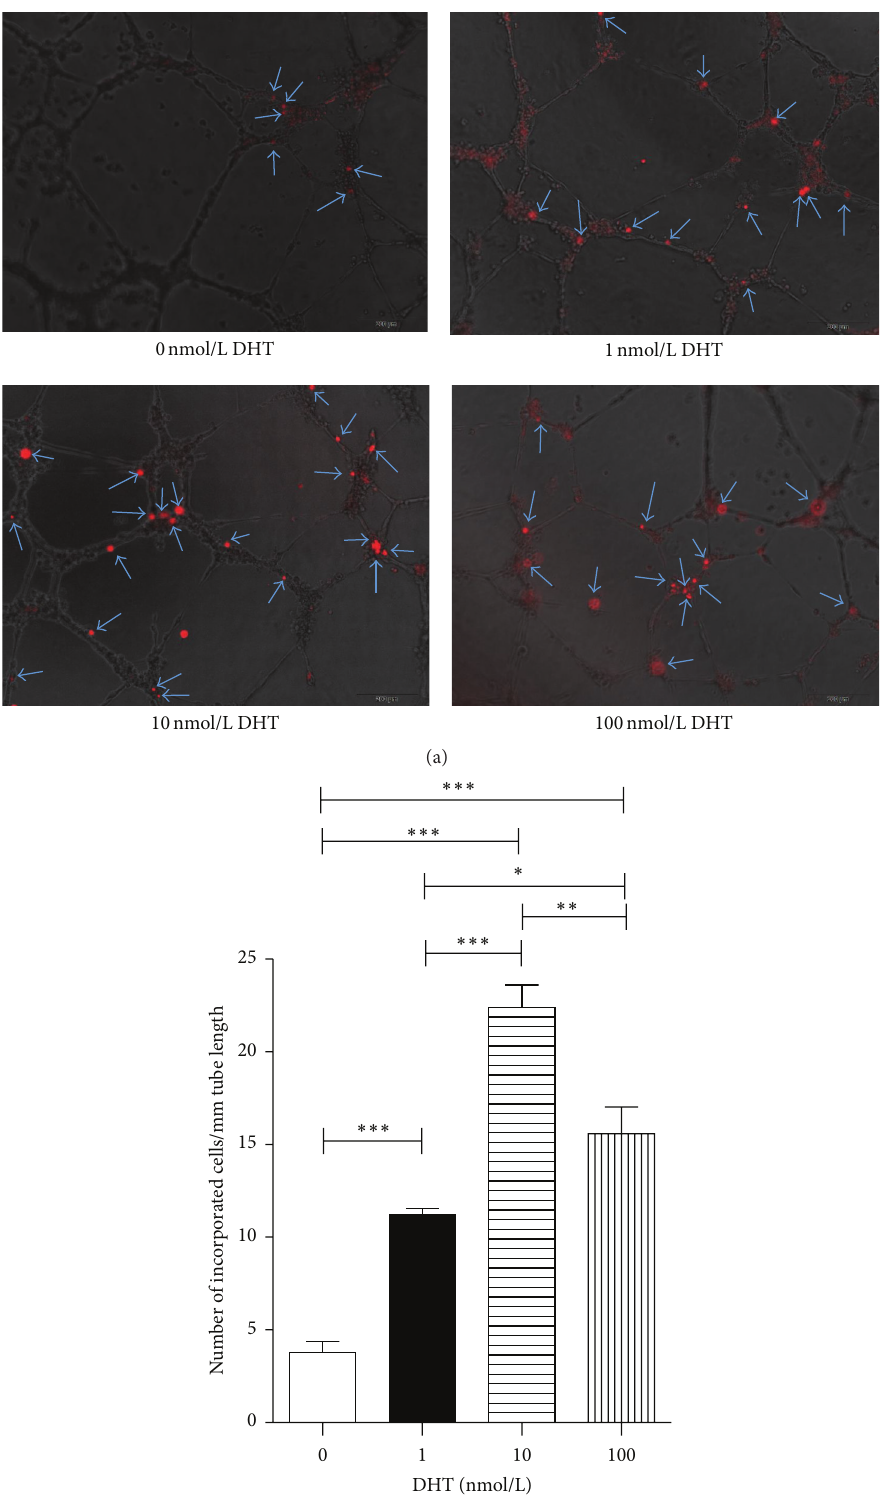
Figure 3: In vitro incorporation assay by HUVECs and incorporated EPCs. DHT-treated or nontreated EPCs were tracked with DiI. DiI- labeled cells and HUVECs were seeded onto Matrigel-coated 96-well plates in 10% FBS/EBM2-MV. After 24 hours in culture, incorporation of each cell population into tube-like structures formed with HUVECs was evaluated under fluorescence microscopy. (a) Incorporated DiI positive cells were indicated by arrows. (b) Number of incorporated cells into tube-like structures was counted and averaged. All assays were triplicated and demonstrated similar results. Data are presented in mean ± SD format. ∗ 𝑃 < 0.05 versus control group, ∗∗ 𝑃 < 0.01 versus control group, and ∗∗∗ 𝑃 < 0.001 versus control